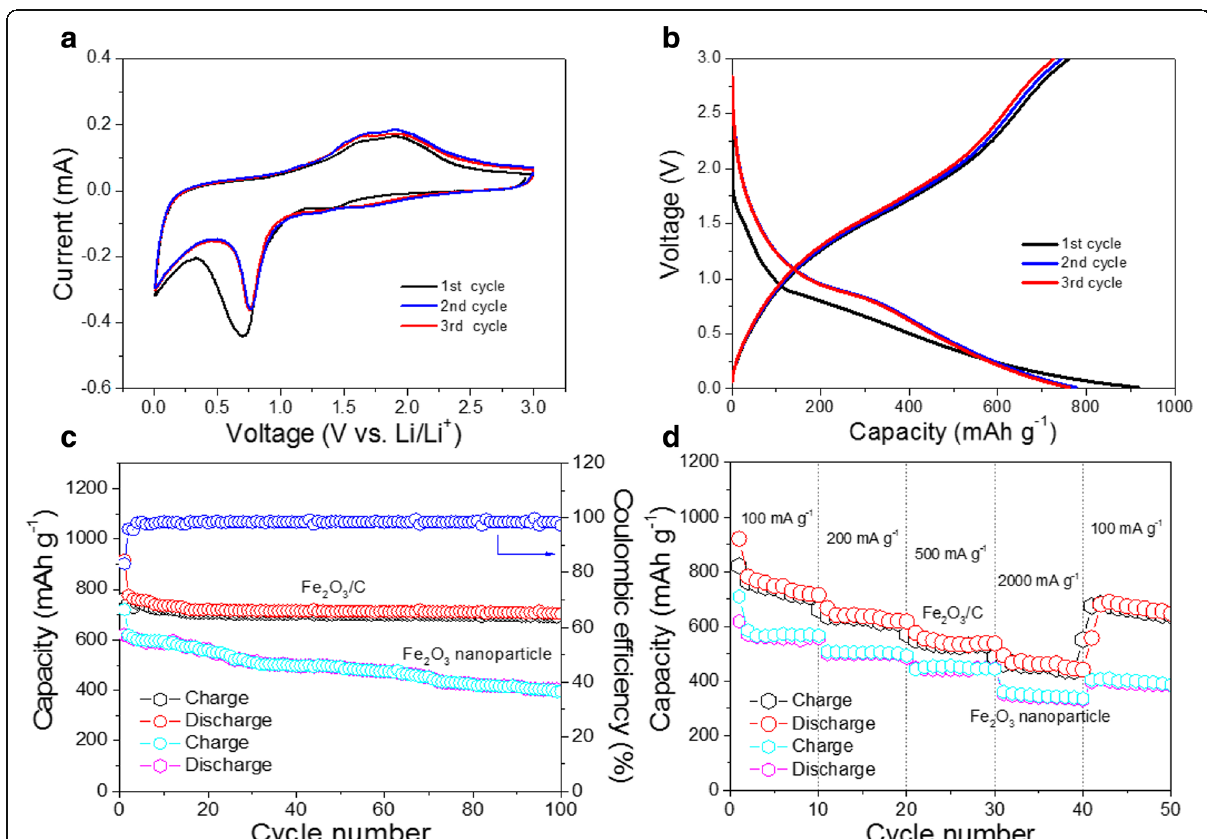
Fig. 4 The cyclic voltammogram ( a ) and voltage profiles ( b ) of the Fe 2 O 3 /C composite at the first, second, and third cycle. c Cycle performance of Fe 2 O 3 /C and Fe 2 O 3 nanoparticles at 100 mA g − 1 . d Rate capability of Fe 2 O 3 /C and Fe 2 O 3 nanoparticles with a current density ranging from 100 to 2000 mA g −